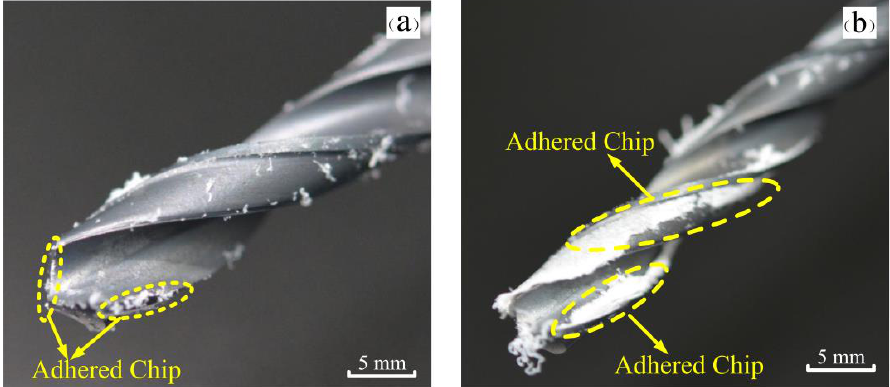
Figure 12. Pictures of chip adhesion at different drilling depths: ( a ) Drilling depth of 10 mm; ( b ) Drilling depth of 30 mm.